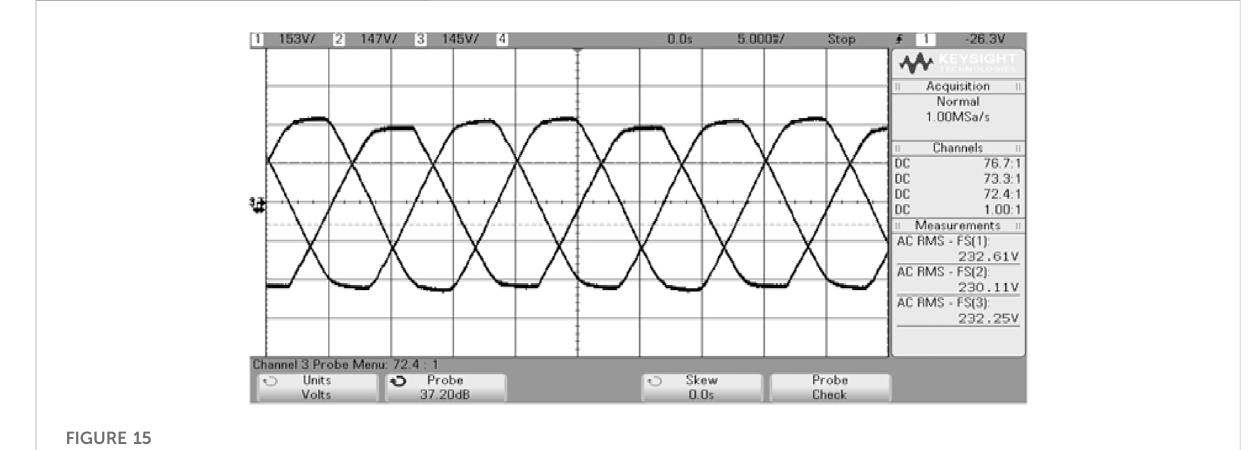
FIGURE 15 Three-phase voltage.